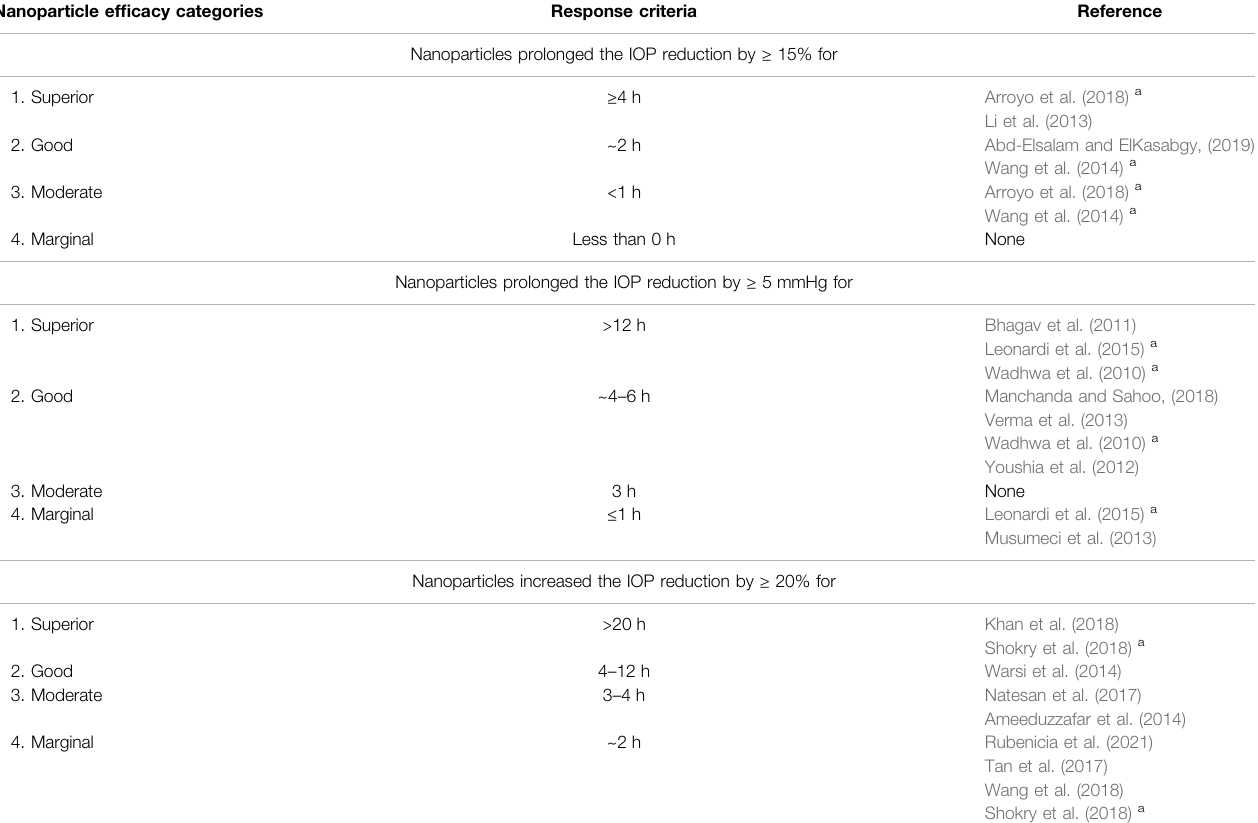
TABLE 3| Categorization ofnanoparticle ef fi cacybased on response criteria when evaluating in vivo ef fi cacyof nanoencapsulation ofanti-glaucoma drugs when compared to non-encapsulated drug, in the reviewed studies. Nanoparticle ef fi cacy